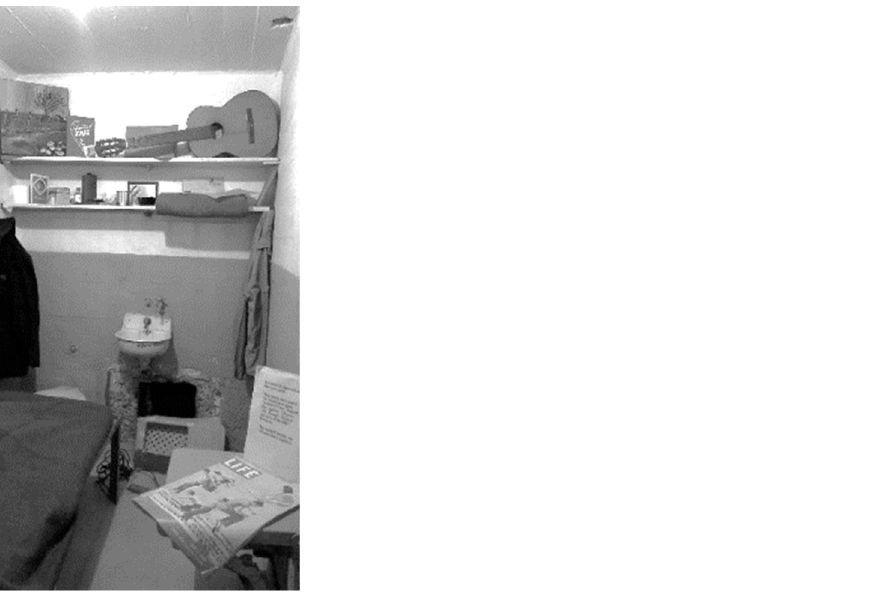
Figure 16. Musical instrument and artwork belongings at a cell inside Alcatraz.